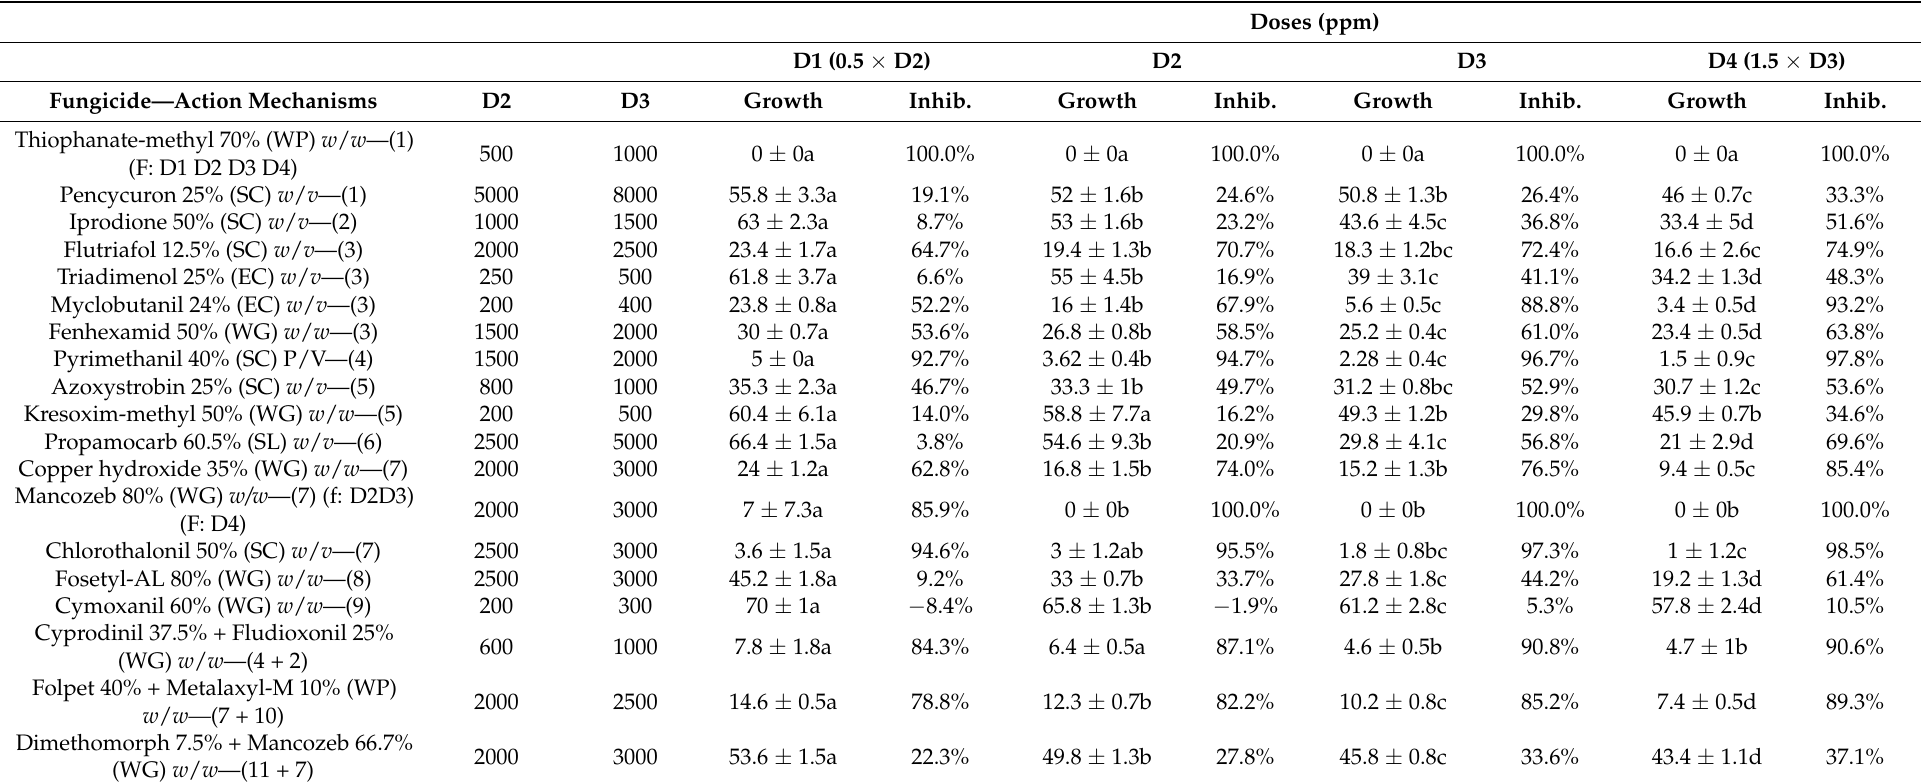
Table 1. Effect of different fungicides on mycelial growth of P. variotii at different doses (D1–D4). Mean values ( ± standard deviation) followed by different letters (line) indicate significant differences ( p < 0.05) by least significant difference test (LSD). (1) Cytoskeleton and motor proteins, (2) signal transduction, (3) sterol biosynthesis in membranes, (4) amino acids and protein synthesis, (5) respiration, (6) lipid synthesis or transport/membrane integrity or function, (7) chemicals with multi-site activity, (8) host plant defence induction, (9) unknown mode of action, (10) nucleic acids metabolism, and (11) cell wall biosynthesis. Fungicide/fungistactic action (red letters): F: Fungicide; f: